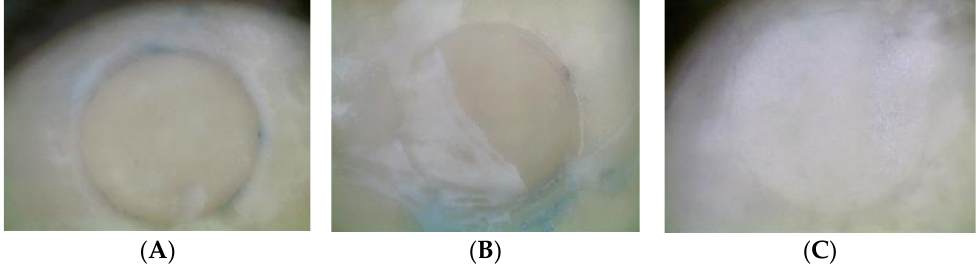
Figure 5. Representative images of failure patterns after the shear test: ( A ) unclassified failure; ( B ) mixed failure; ( C ) adhesive failure.